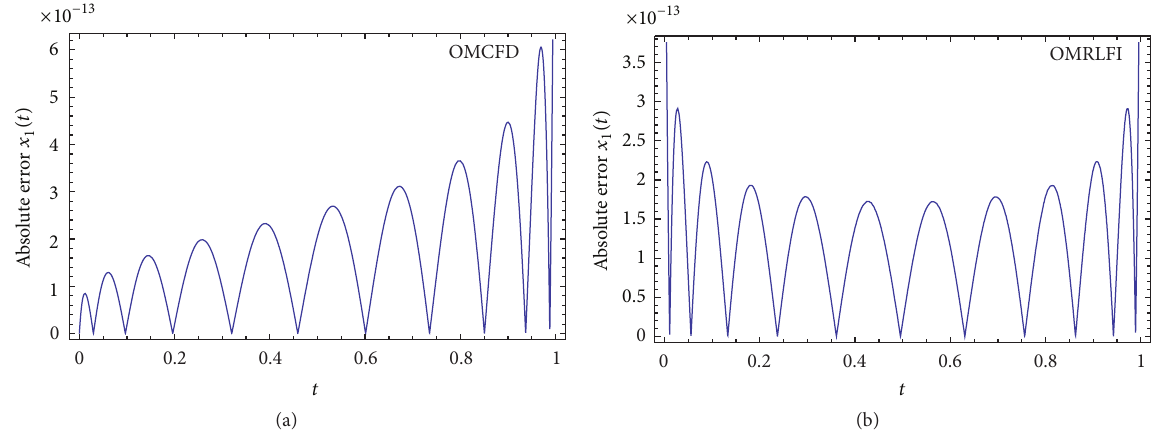
Figure 3: Plot of absolute error function 𝑥 1 (𝑡) for 𝛼 1 = 𝛼 2 = 1 and 𝑚 = 10 by OMCFD and OMRLFI in Example 12.